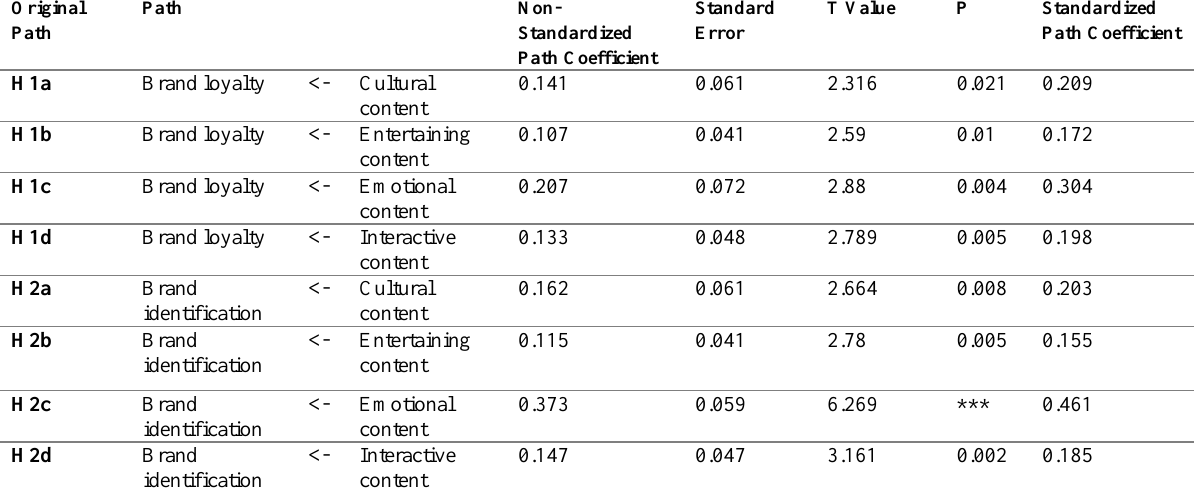
Table 6: Path coefficient analysis between